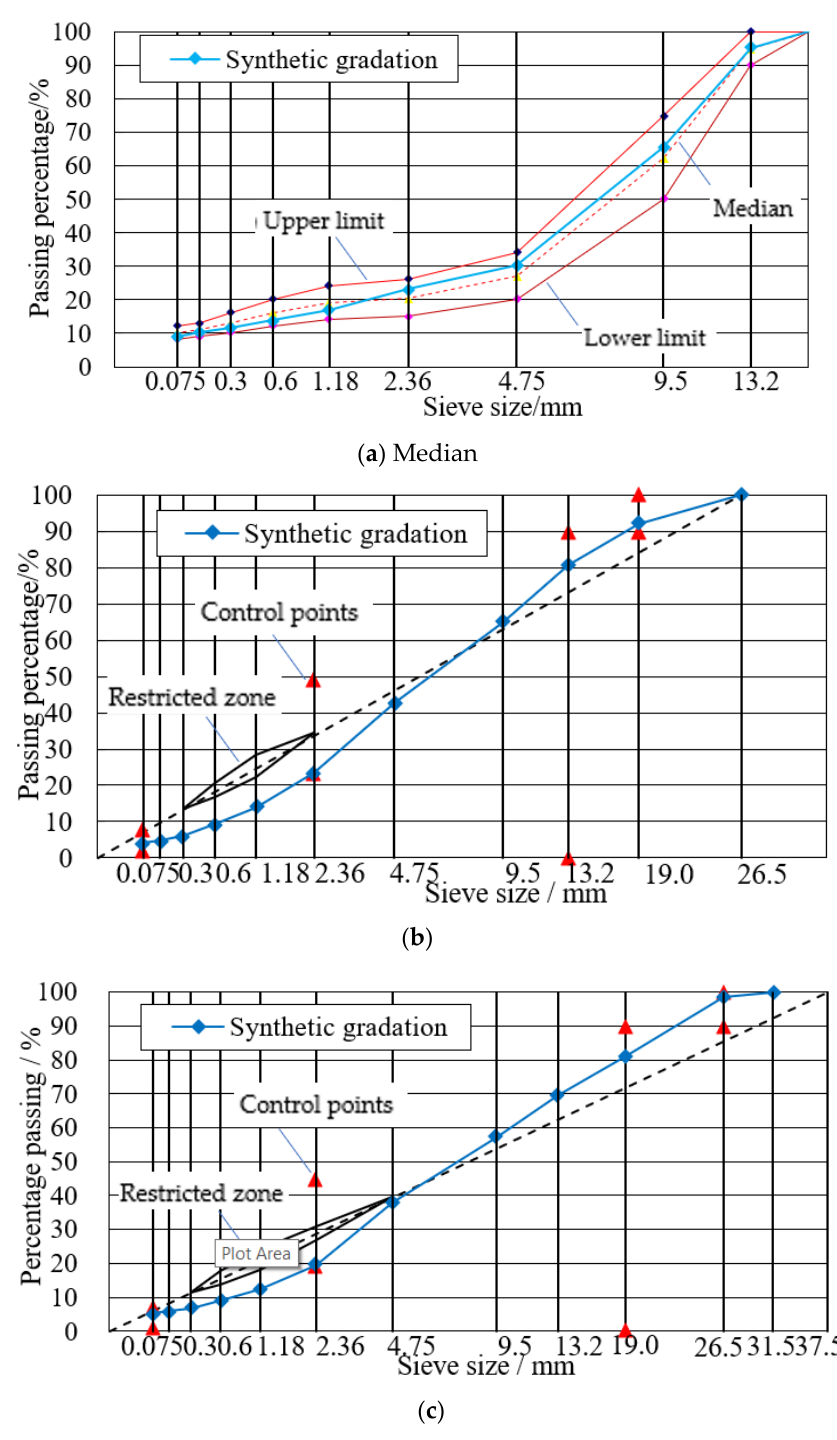
Figure 3. Gradation curves: ( a ) SMA-13; ( b ) SUP-20; ( c ) SUP-25. Table 4. Details of the asphalt mixture samples.